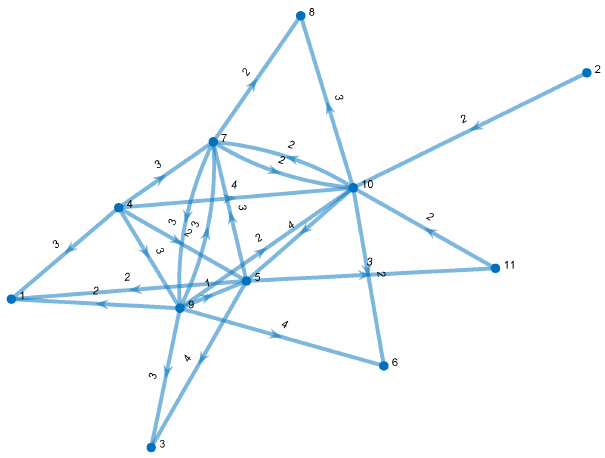
Figure 1. Inter satellite link directed